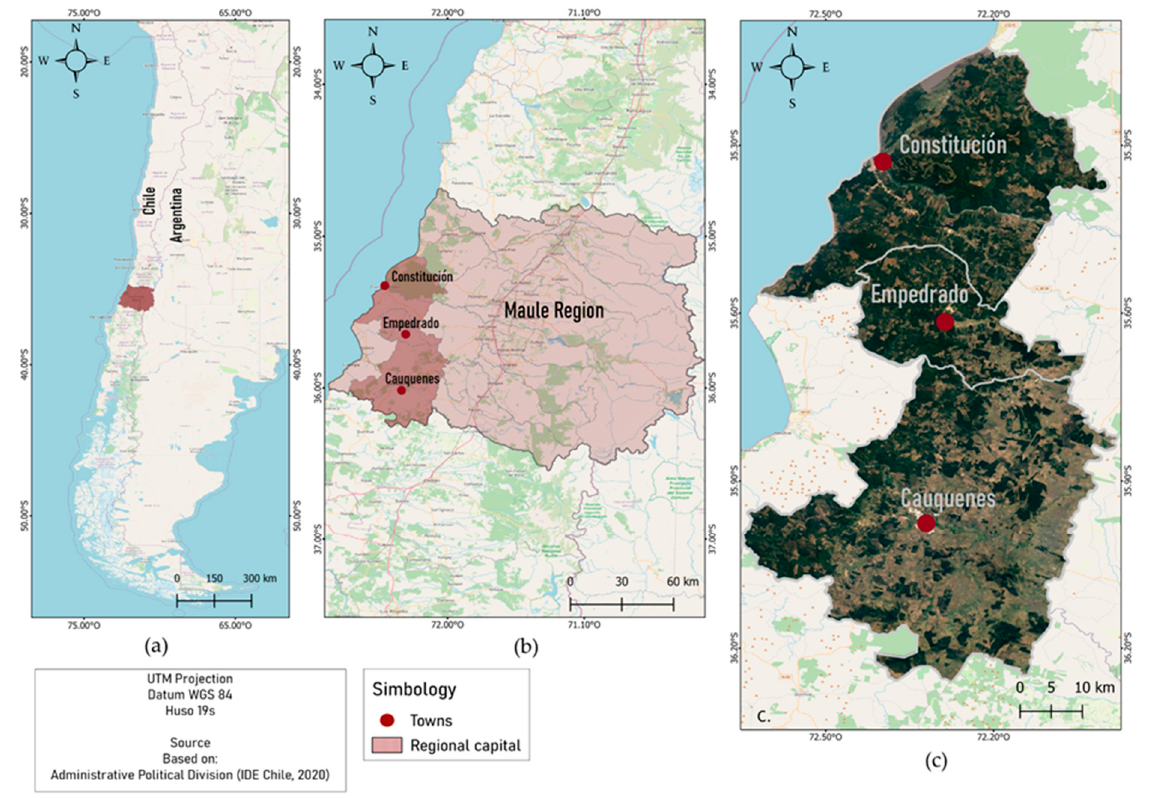
Figure 1. ( a ) Location of the study area in Chile. ( b ) Location of the study area on a regional scale. ( c ) Communal scale study area.